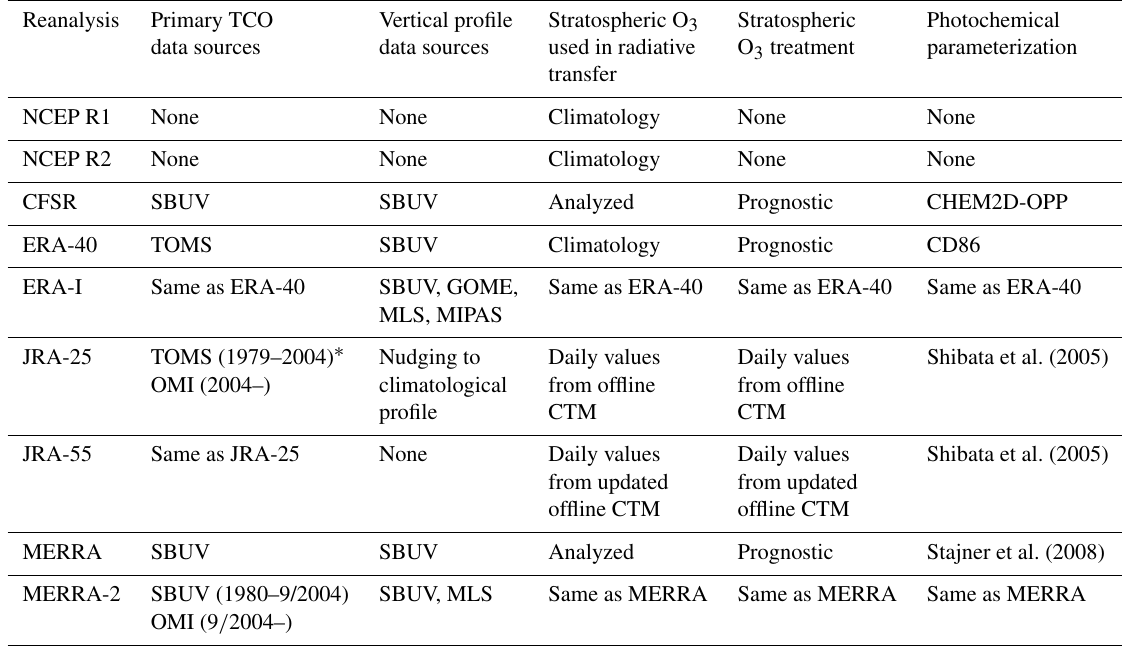
Table 1. Key characteristics of ozone treatment in